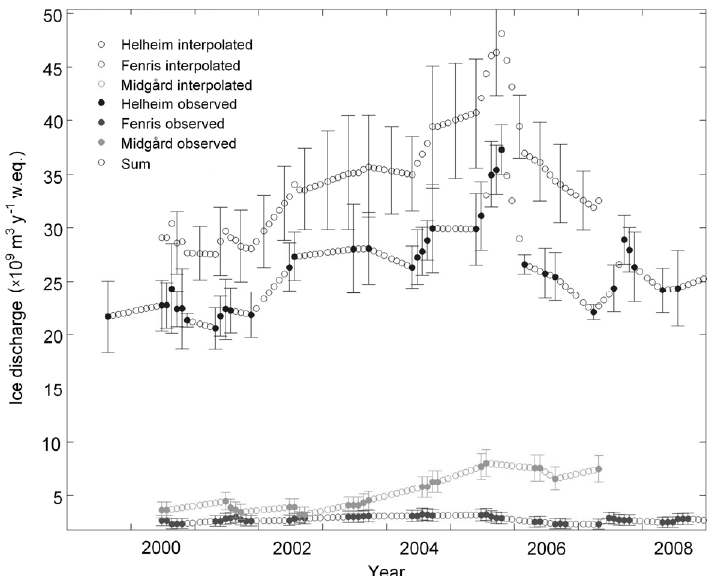
Figure 6: Satellite-derived time series for the period 1998–2008 of ice velocity, ice thickness, and ice discharge at a stationary flux gate within 3 km of the most-retreated front position of the three major outlet glaciers: Helheim Glacier, Fenris Glacier, and Midgård Glacier draining into the Sermilik Fjord. Ice thickness observations (denoted by vertical error bars) were linearly interpolated, denoted by the curve, and multiplied by constant glacier width and observations of ice velocity and the ratio of water and ice densities (0.91) to obtain discharge of water. Ice discharge data for Helheim Glacier reported here are updated from Howat et al. (2005, 2007). Fenris and Midgård Glaciers are located in sub- area 3 and Helheim in sub-area 4. Figure 7: Average monthly ice discharge observations (closed circle) and linearly- Fig. 7. Average monthly ice discharge observations (closed circle) and linearly-interpolated values (open circle) for Helheim Glacier, Fenris interpolated values (open circle) for Helheim Glacier, Fenris Glacier, and Midgård Glacier, Glacier, and Midg˚ard Glacier, and sum of the three glaciers for the period 1999 through and sum of the three glaciers for the period 1999 through 2008. 29